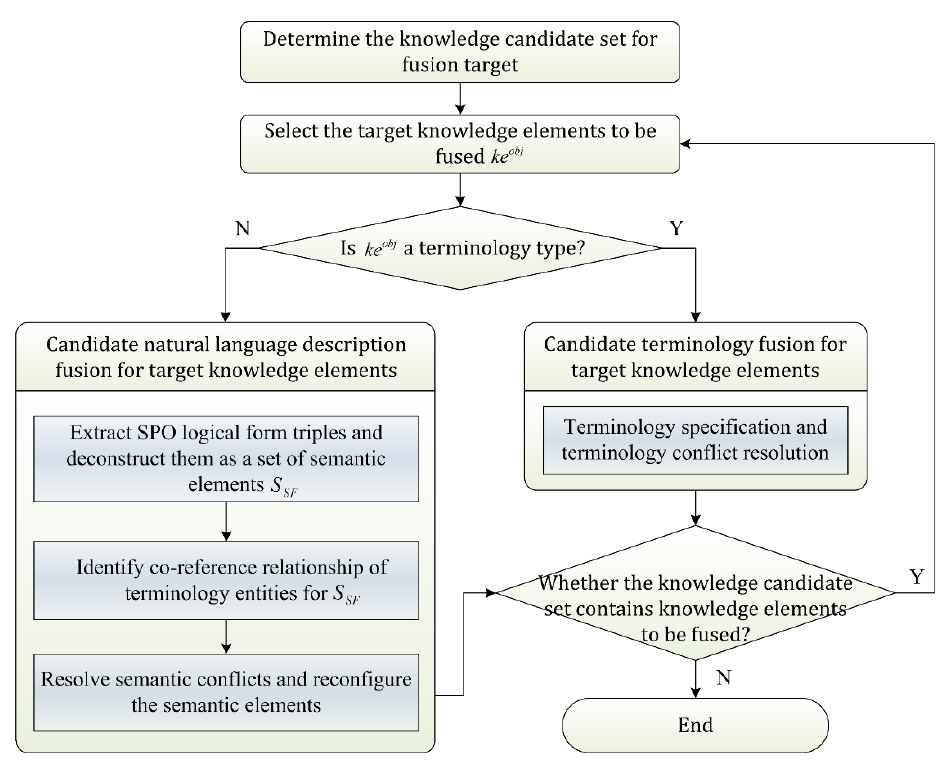
Figure 3. Algorithm flow of process innovation knowledge fusion based on semantic elements reconfiguration.